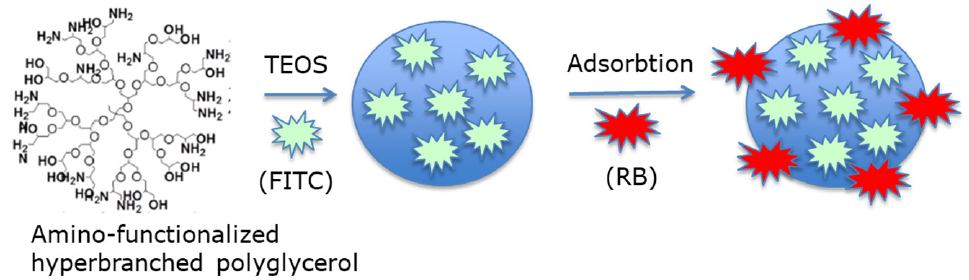
Figure 22. Preparation of polyglycerol MSNs with adsorbed fluorescein isothiocyanate (FITC) and RB. Adapted from Liu et al.